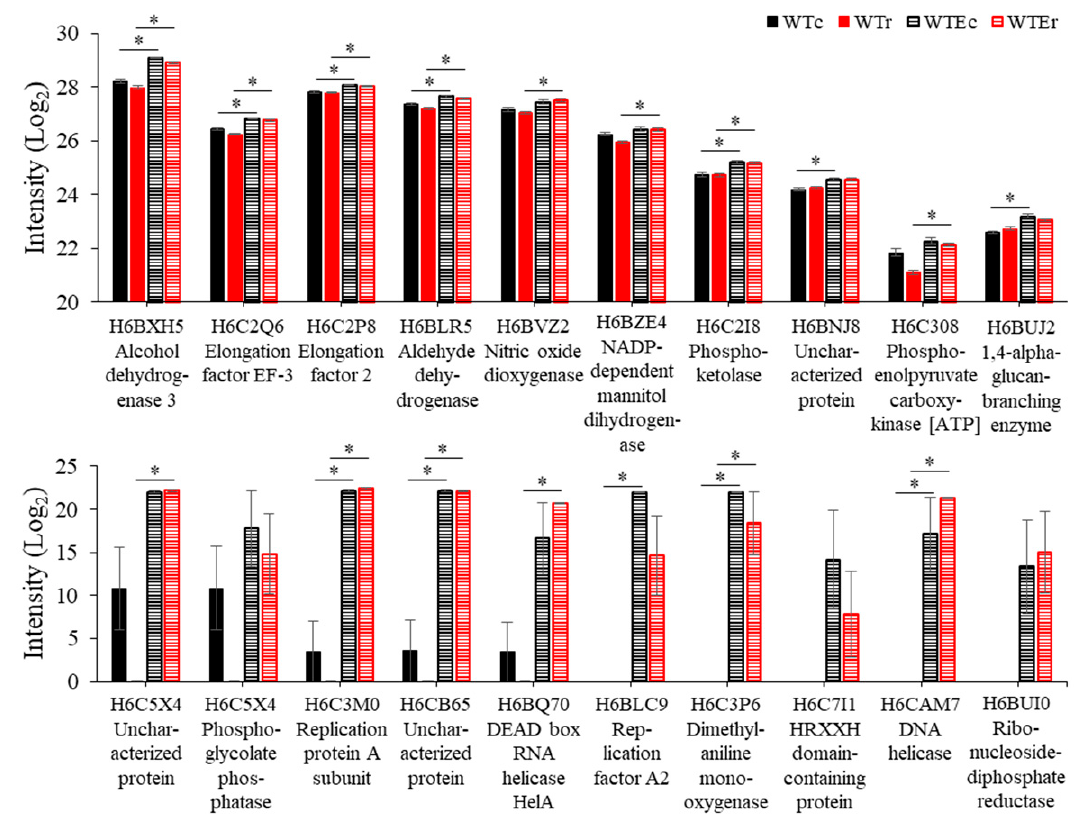
Figure 5. Intensity levels of non-ribosomal proteins increased in the Evolved strains, in comparison with WT strains. Note that only a portion of the Y axis is shown in the upper panel to highlight the small, but significant, di ff erences in intensity levels. Error bars represent standard error. Asterisks indicate instances of statistically significant